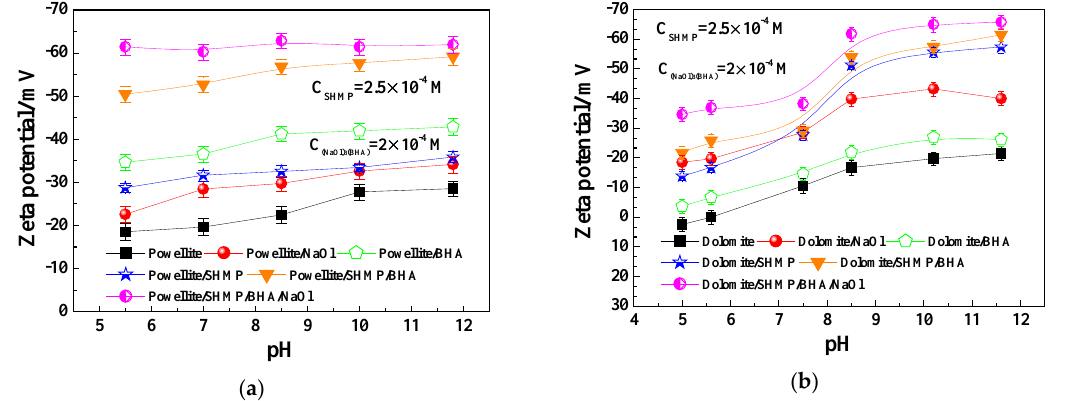
Figure 6. Zeta potential of dolomite ( a ) and powellite ( b ) before and after interaction with di ff erent reagents as a function of pH.